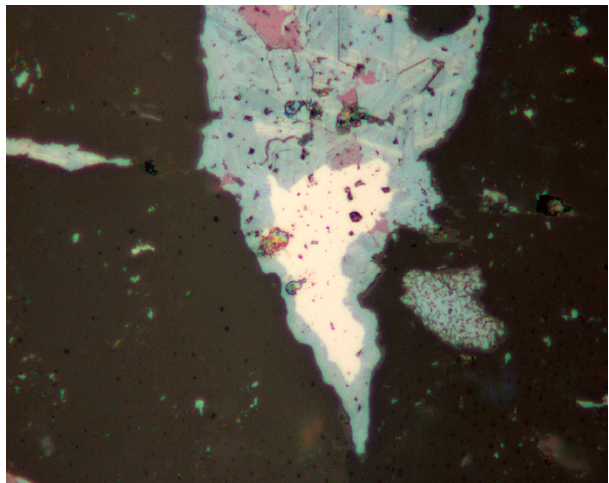
Figure 52. Yellowish-pink giraudite anhedral grain replacing by blue-green berzelianite which is partly replaced by violet umangite. Reflected light, one polarizer. FOV 210 μ m. P ř íbram, a dump of shaft 16. Photo by P. Škácha.